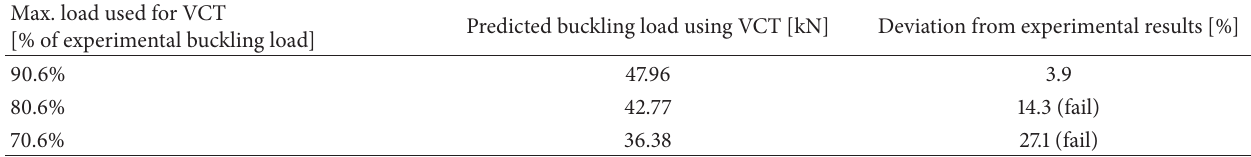
Table 11: Buckling load prediction using the VCT approach for different loading ranges on SST-2 cylinder (second vibration